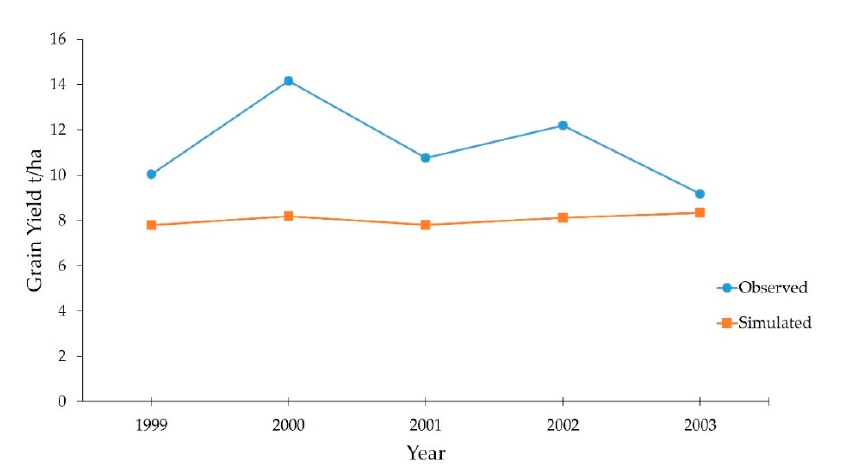
Figure 3. Simulation with default parameters showing the simulated yields for the weather period with observed data.